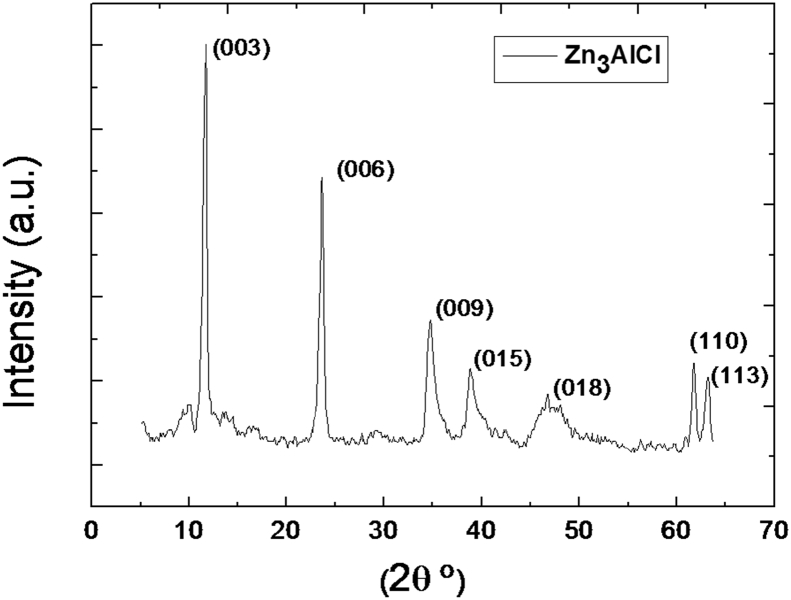
XRD pattern of Zn3–Al–Cl